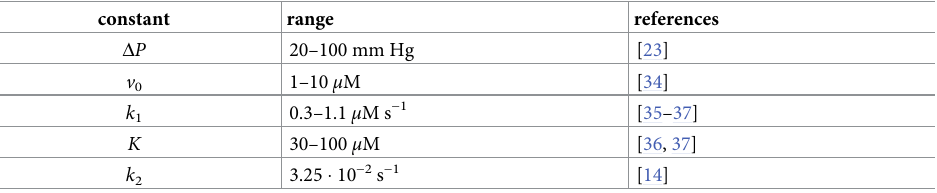
Table 1. Parameter ranges governing the overall blood flow, the plasma concentration and the active transport of L-Dopa. The precise values used in each simulation are listed in the figure captions. constant